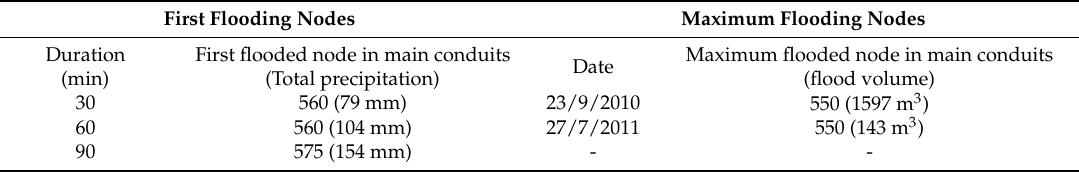
Table 3. First and maximum flooding nodes in the drainage system as potential monitoring